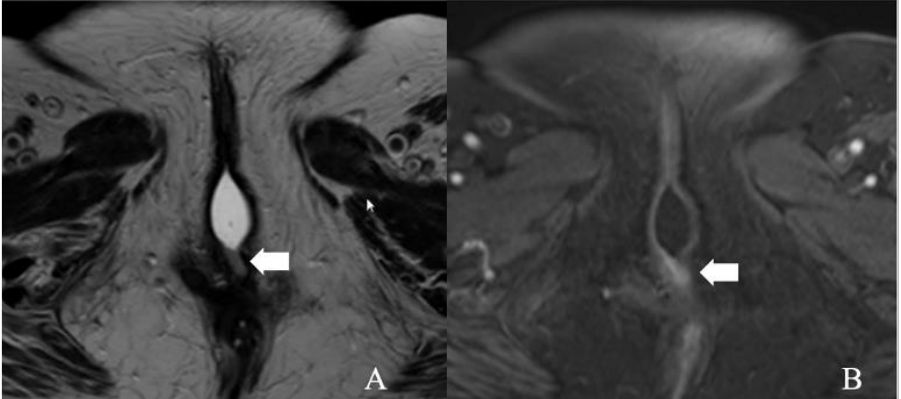
Figure 3. FIGO stage IA. A 43-year-old female with squamous cell carcinoma of the vulva. ( A ) Axial T2 weighted image and ( B ) post-contrast fat-saturated axial T1 weighted MRI image showing an enhancing 1.3 × 0.6 cm T2 intermediate signal biopsy-proven vulvar tumor (arrow).